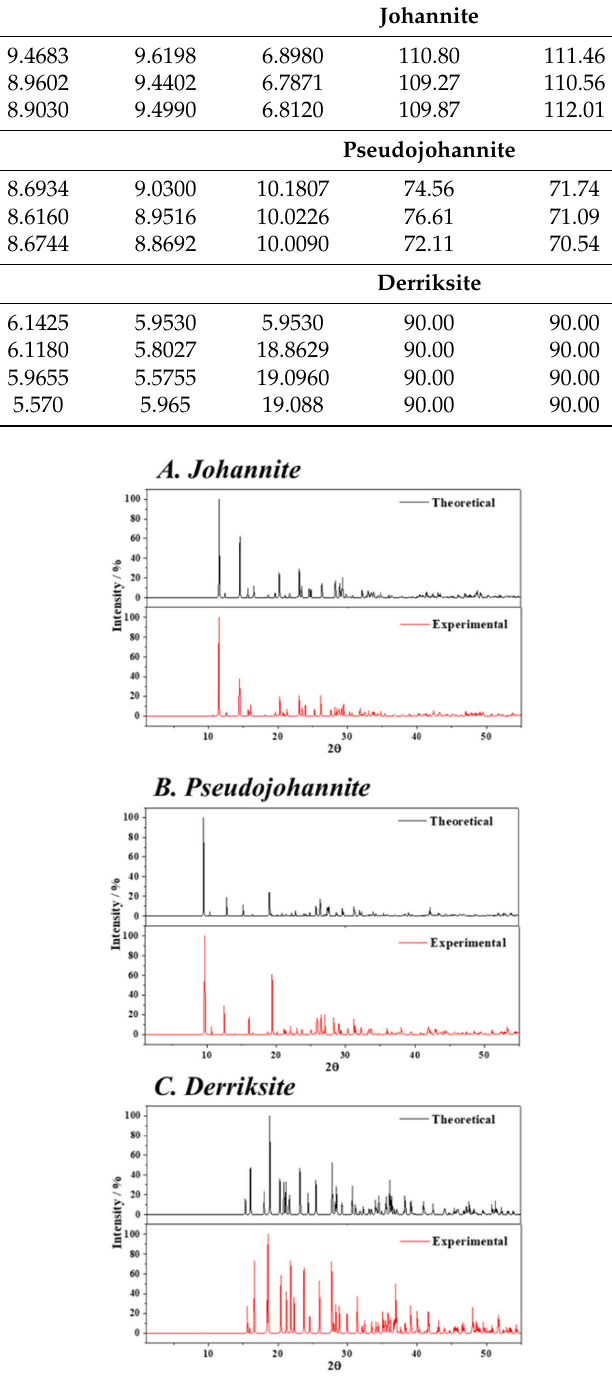
Figure 2. X-ray diffraction patterns of johannite, pseudojohannite and derriksite derived from experimental [16,24,27] and theoretical crystal structures .